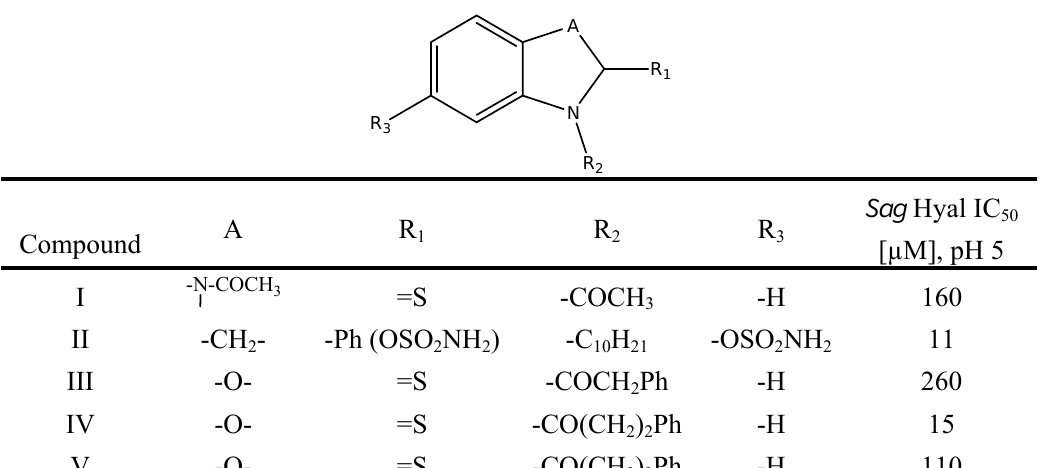
Table 1 . Inhibitors of bacterial hyaluron lyase as synthesized, tested and published recently by Buschauer and colleagues